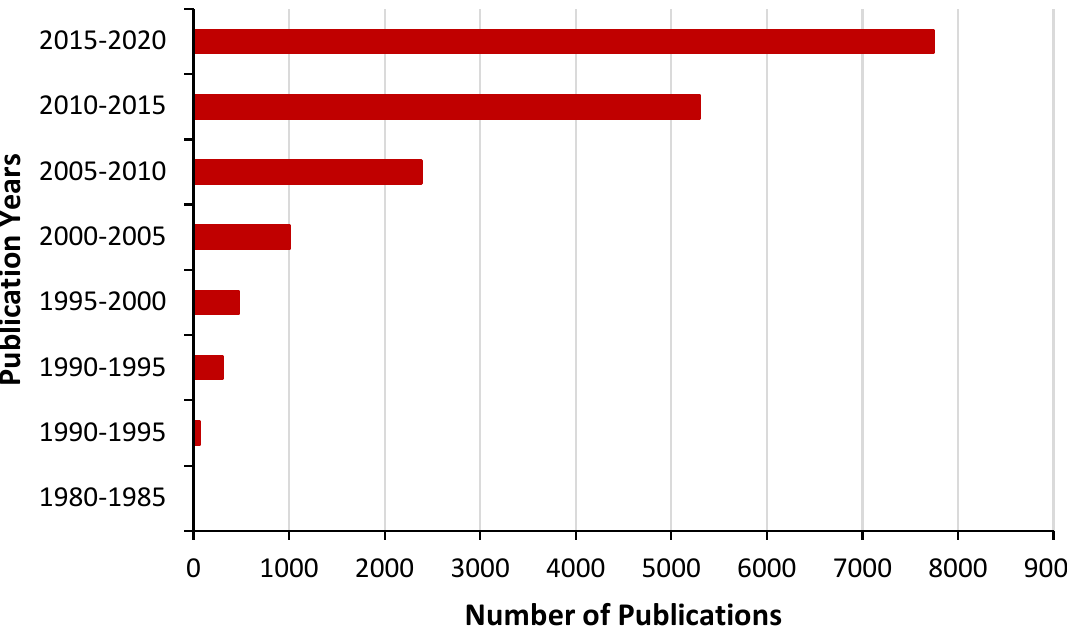
Figure 1. Publications statistics for “Biomarkers in Alzheimer’s disease”, source PubMed.